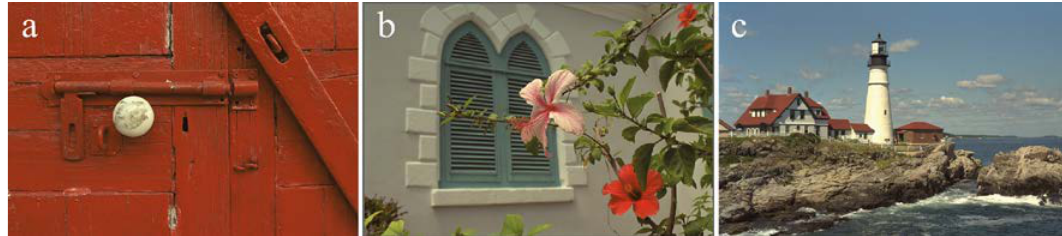
Figure 3. Examples of the ground truth images. ( a ) Img02: “RedDoor.png”; ( b ) Img07: “Flowers.png”; ( c ) Img21: “Lighthouse.png.”.